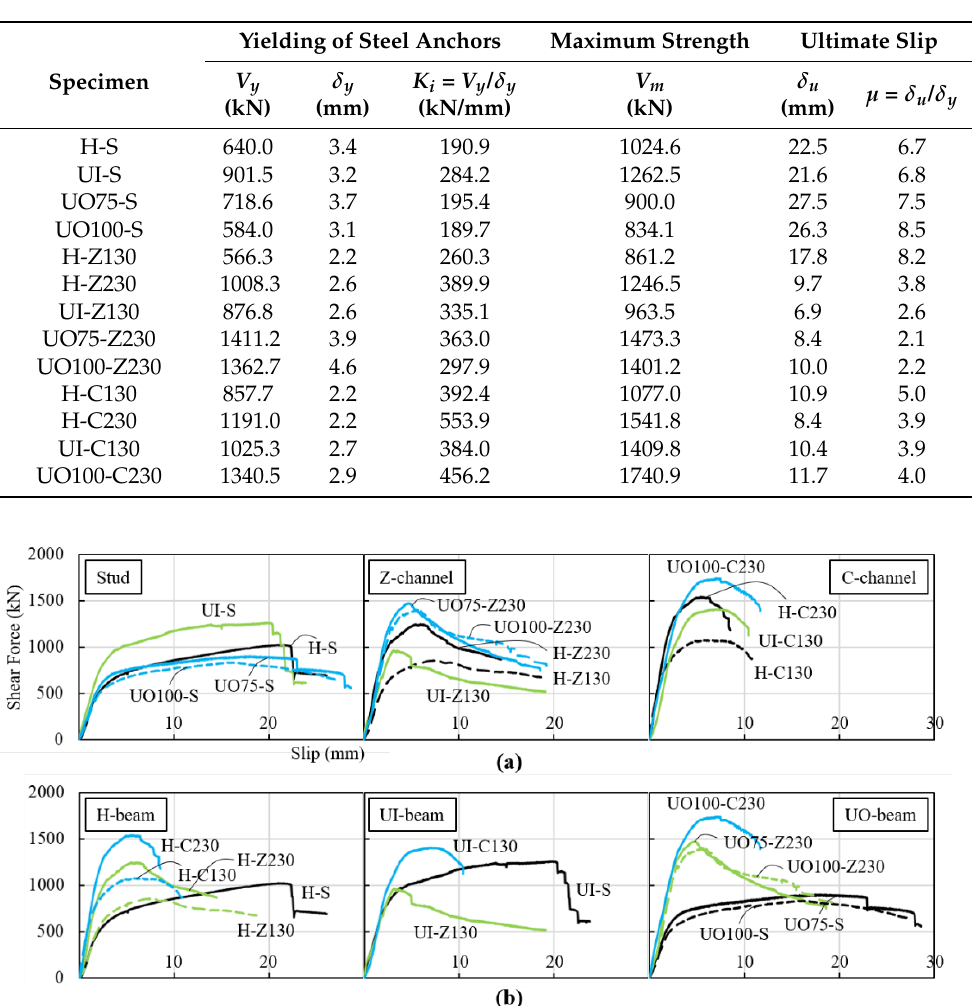
Figure 7. Comparisons of Behavior: ( a ) in terms of Steel Anchors; ( b ) in terms of Steel Beams.